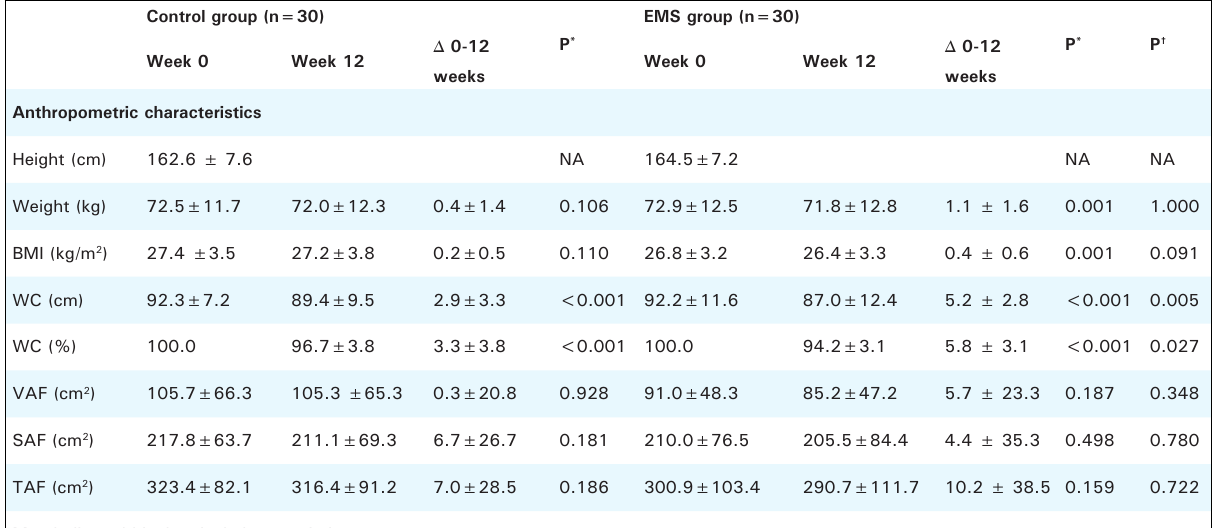
Table 3. Changes in anthropometric, metabolic, and biochemical characteristics between baseline and week 12 (ITT analysis